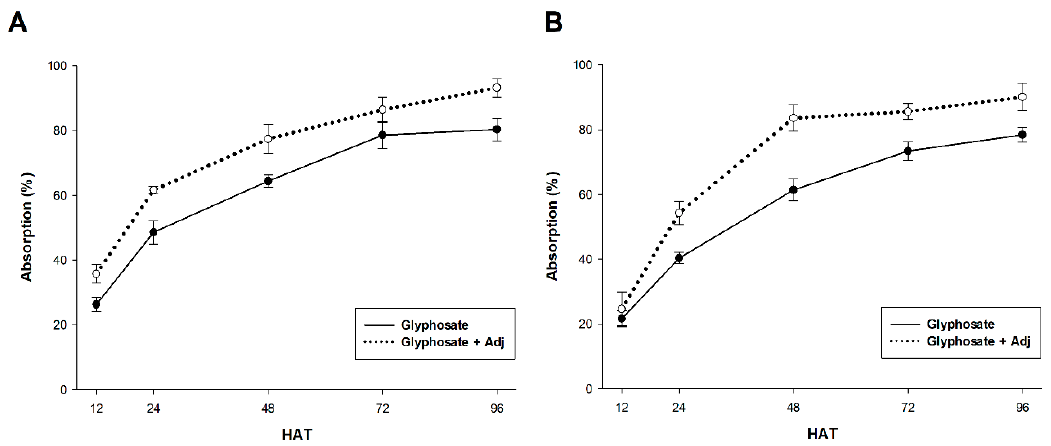
Figure 2. Absorption of 14 C-glyphosate from 12 to 96 h after treatment (HAT) in C. canadensis ( A ) and L. rigidum ( B ) populations. The vertical bars represent the standard error of the mean (n = 5). Table 3. 14 C-glyphosate absorption and translocation 96 HAT in C. canadensis and L. rigidum populations.